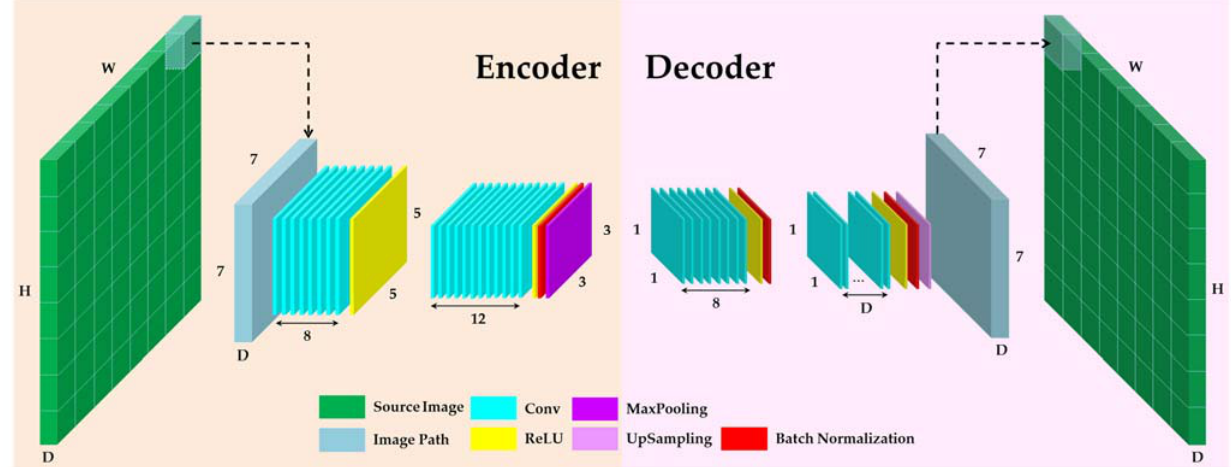
Figure 3. The architecture of the CAE.